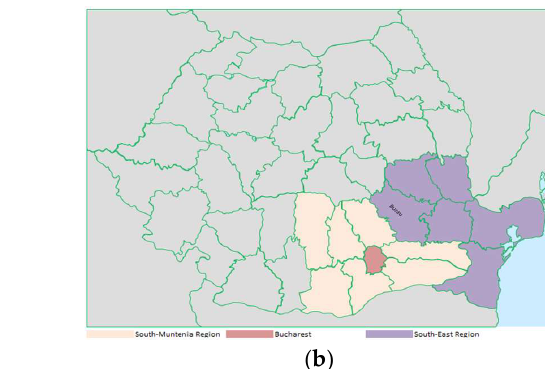
Table 8. Frequency table by clusters and by regions.